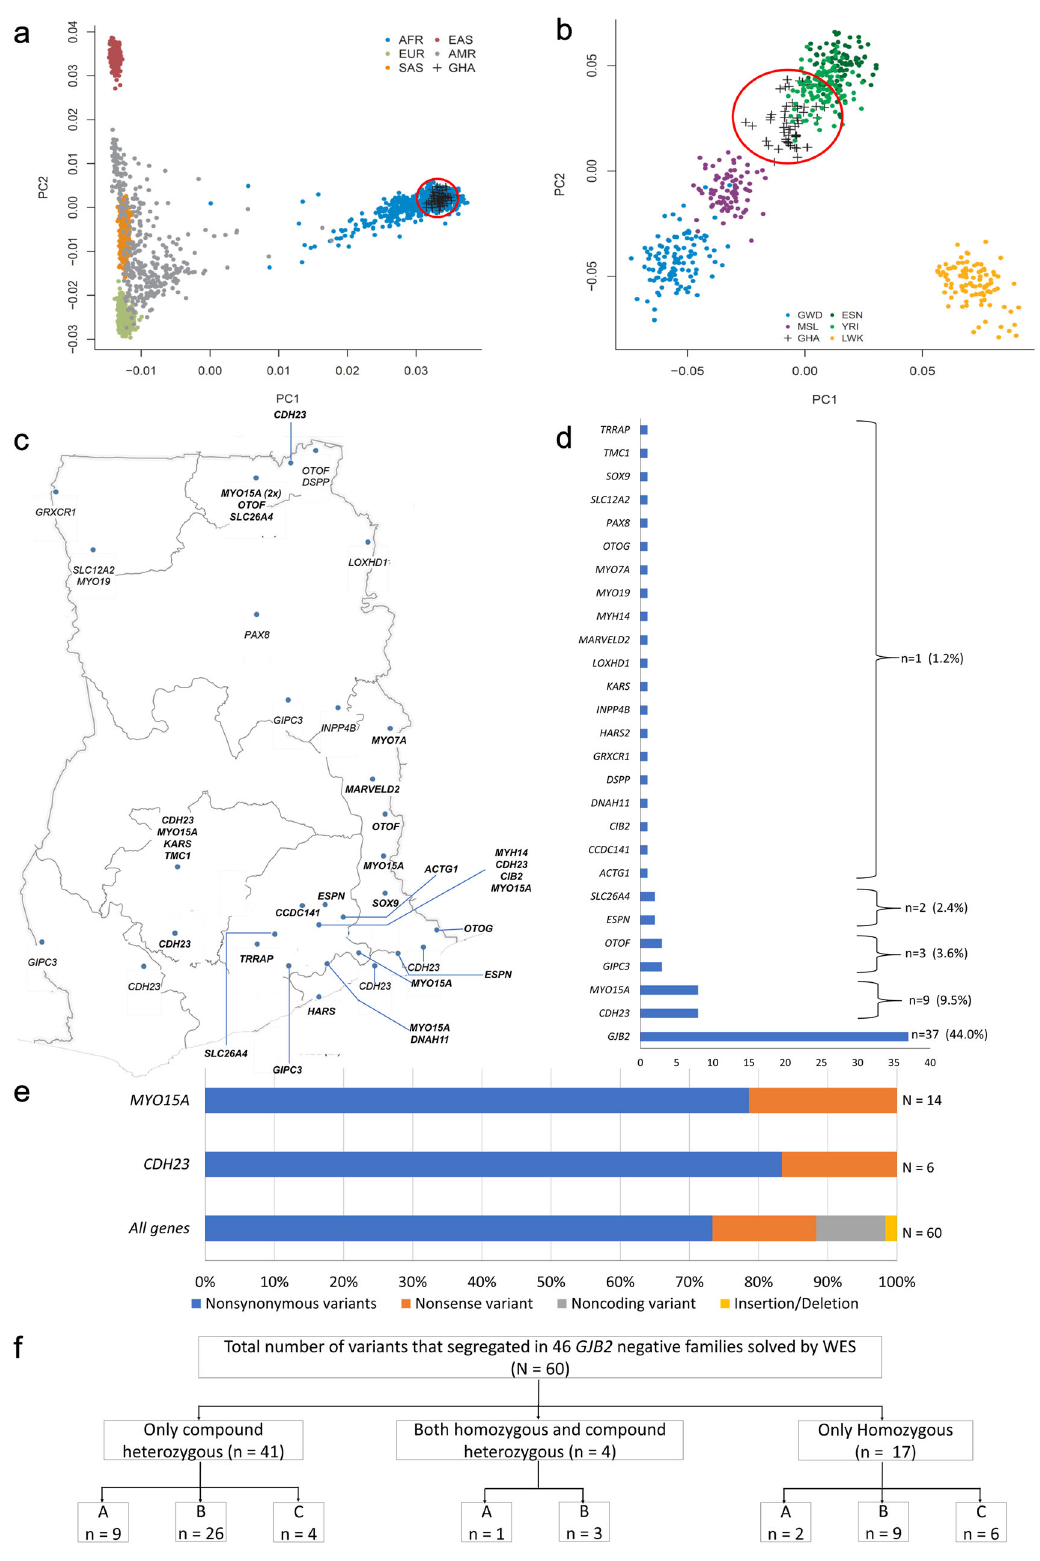
Fig. 2 Principal component analysis and overview of gene variants found in Ghana. PCA plot of samples from Ghana projected against the a global populations and b African populations. GHA samples from Ghana (highlighted with red circles), AFR Africa, EUR European, SAS South Asian, EAS East Asian, AMR Admixed Americans, GWD Gambian in Western Division, MSL Mende in Sierra Leone, ESN Esan in Nigeria, YRI Yoruba in Ibadan, Nigeria, and LWK Luhya in Webuye, Kenya. c Geographical distribution and d frequency of the known HI and candidate genes in Ghanaian families. e Proportions of variant types in the two most prevalent ( MYO15A and CDH23 ) and other known and novel candidate HI genes were identi fi ed. f A fl ow diagram showing variants absent from the databases “ A ” , present in the databases with new HI association “ B ” and known HI variants “ C ” identi fi ed in the families studied.